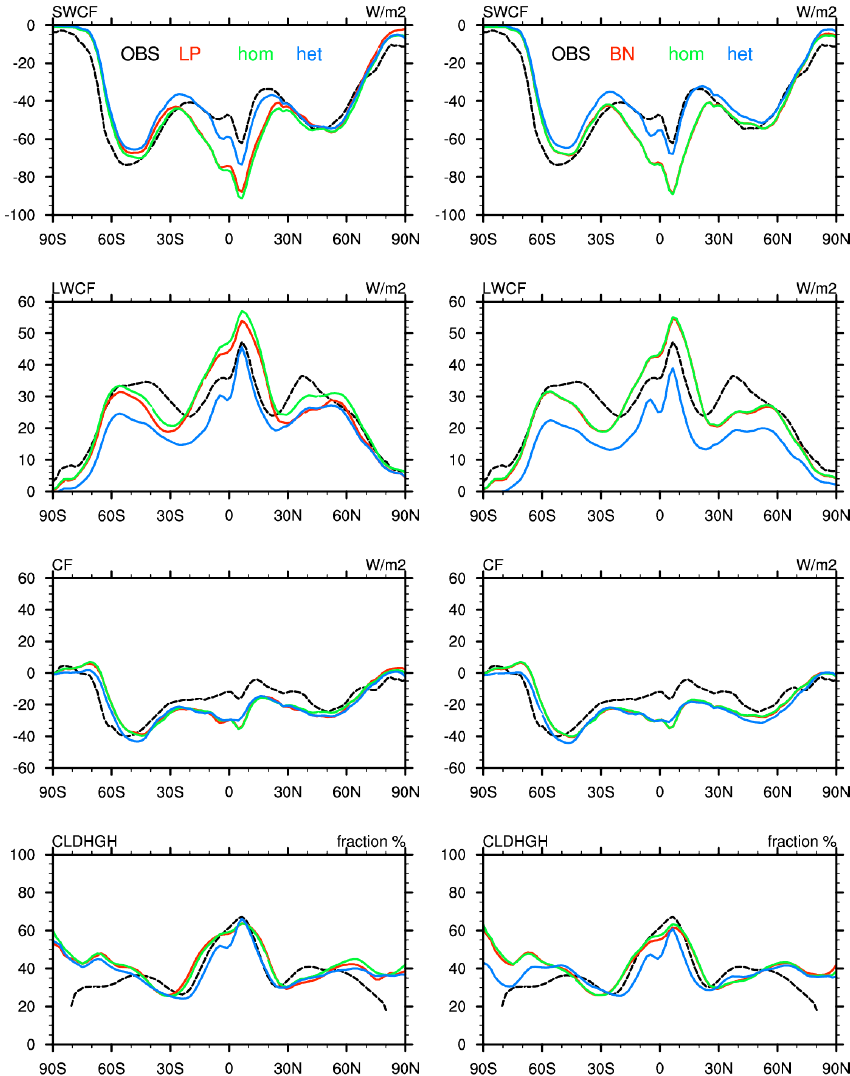
Fig. 9a. Annual and zonal mean distributions of shortwave cloud forcing (SWCF), longwave cloud forcing (LWCF), net cloud forcing (CF), and high cloud cover (CLDHGH) from different model simulations with LP05 (left) and BN09 (right) parameterizations. Black-dashed lines are from